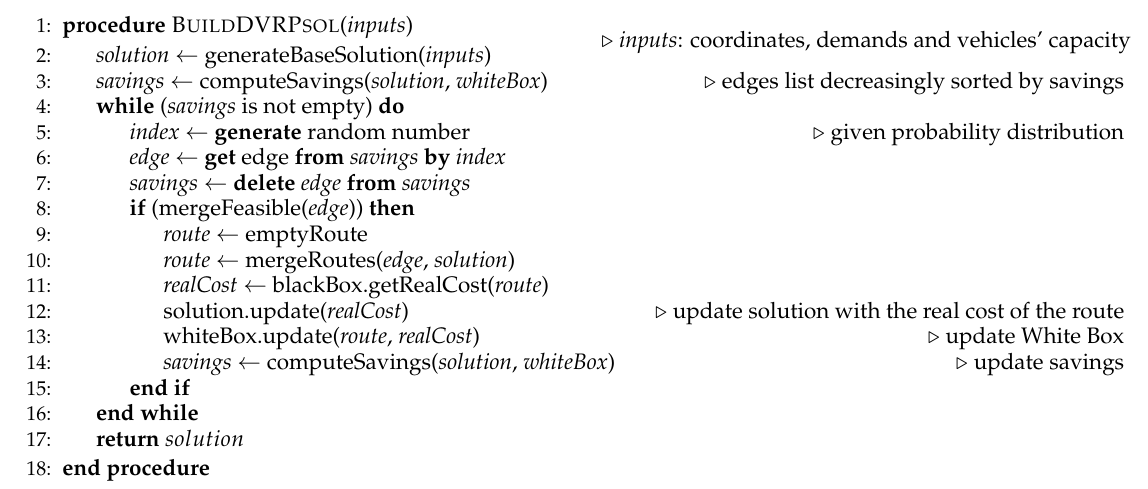
Algorithm 1 Procedure to build a DVRP solution using the BR-CWS heuristic.